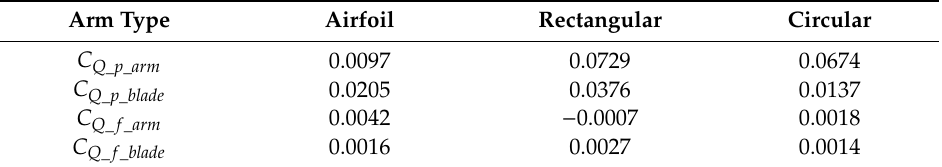
Table 7. Resistance torque coe ffi cients divided into the pressure and friction e ff ects in arms and blades.